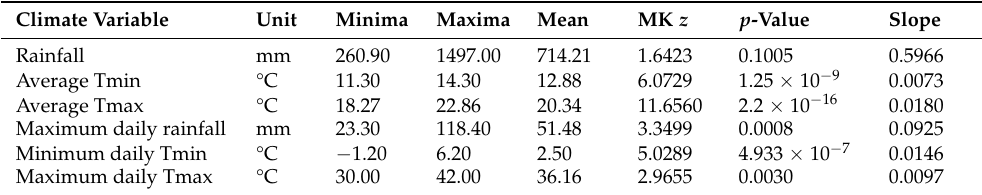
Table 1. Summary of statistics, Mann–Kendall test z , and Sen’s slope estimates (in units per year) related to the annual series of climate variables at the Lisboa-Geofísico station from 1864/65 to 2020/21 ( n = 157) at a significance level of α =